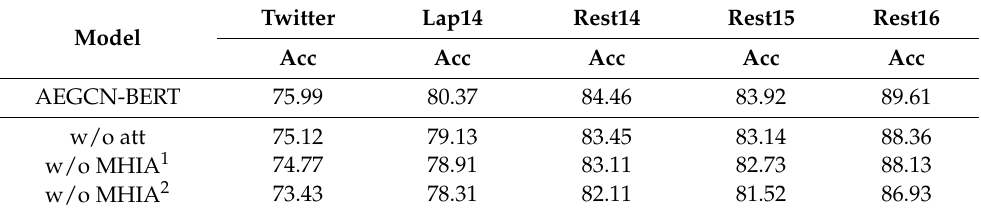
Table 3. Ablation study results of accuracy (%) on five datasets.